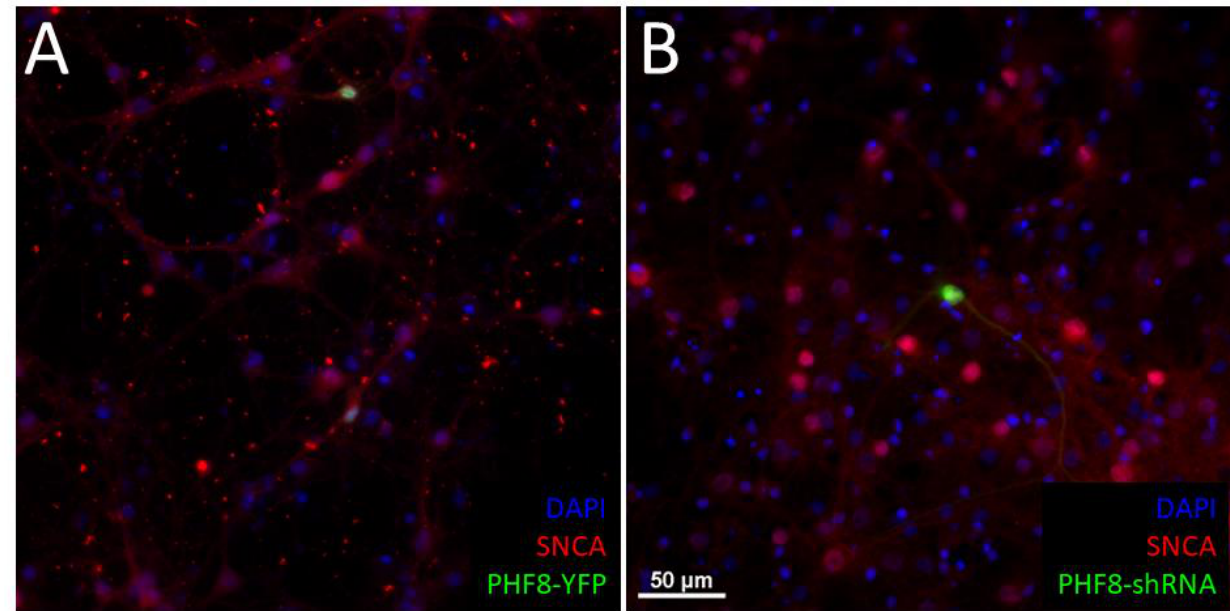
Figure 3. ( A ) A representative image of DIV 21 cortical neurons transfected with PHF8-YFP (in green) immunostained with an antibody against Alpha-synuclein (SNCA, in red) showing that the overexpression of PHF8 does not seem to affect SNCA levels (the level of red signal did not change compared to other neurons that are not transfected with green and due to the mixture of red and green the cell has turned slightly yellow). Scale bar = 50 um. ( B ) Transfection of a shRNA plasmid against PHF8 results in a qualitative reduction of SNCA (the green neuron does not turn yellow; not quantified).